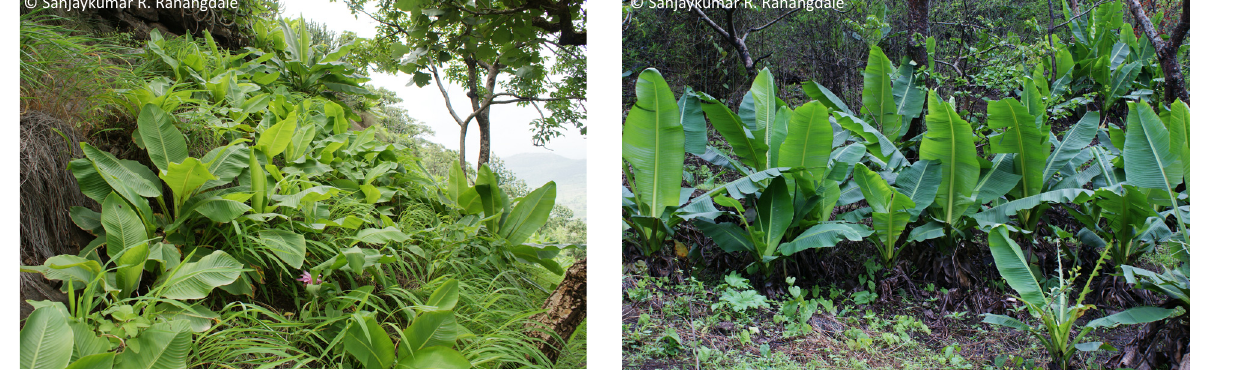
Image 4. Population of Ensete superbum seedlings